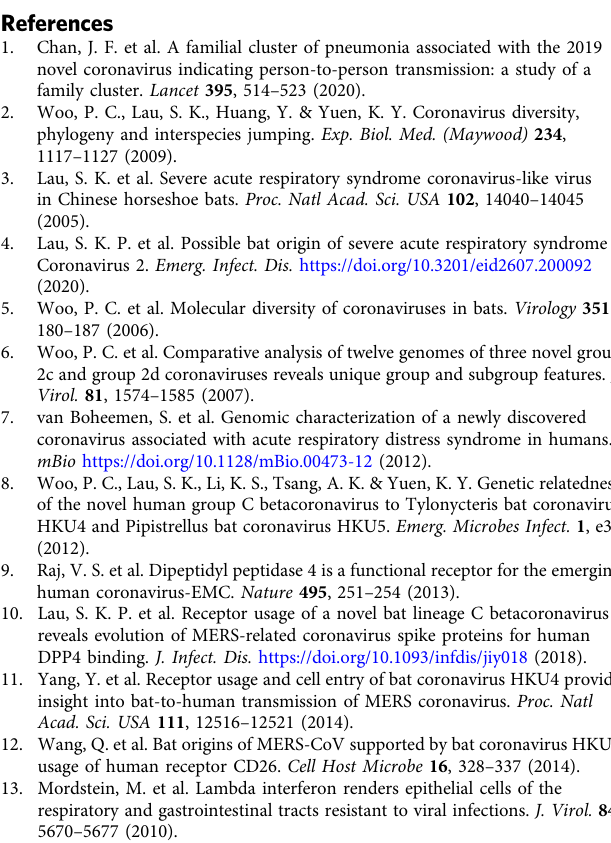
Table 9 with mouse β -actin for normalization 38 . RT-qPCR was performed using FastStart Universal SYBR Green Master kit (Roche) in LightCycler 2.0 (Roche). The relative expression between Ty -BatCoV HKU4-infected and -uninfected transgenic mice for each gene was calculated by the comparative ΔΔ CT method. Reporting summary . Further information on research design is available in the Nature Research Reporting Summary linked to this article. Data availability The nucleotide sequences of the complete S and genome sequence of Ty -BatCoV HKU4 strains have been lodged within the GenBank sequence database under accession no. MW218376-MW218394 and MW218395 respectively. Source data are provided with this